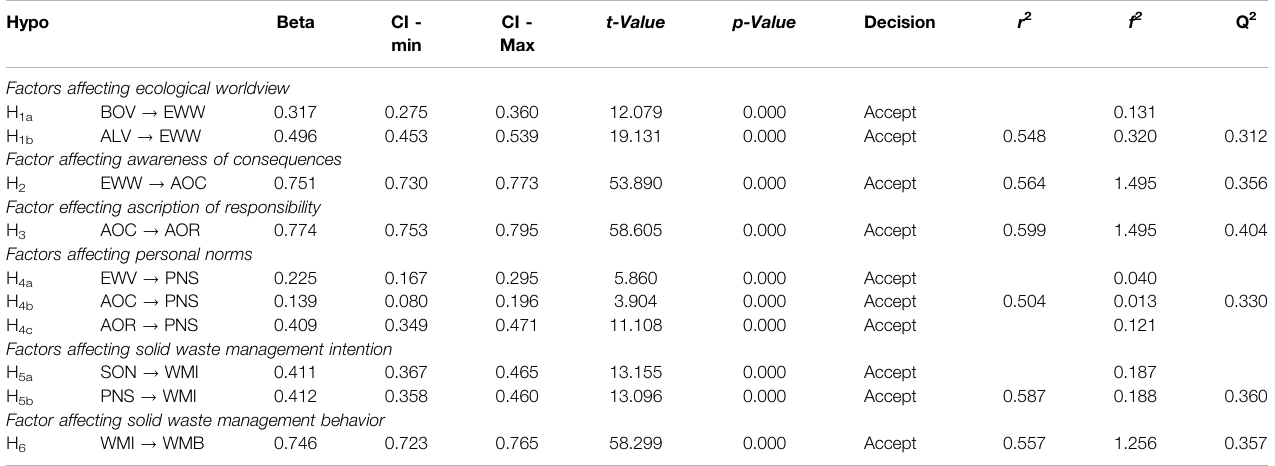
TABLE 4 | Hypothesis